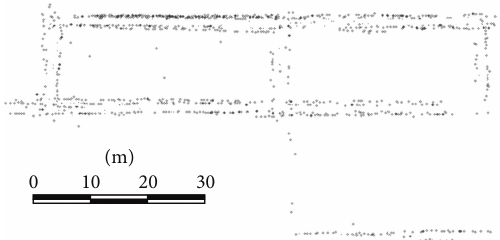
algorithm, showing the landmarks added to the map, representing the structure of the environment. All measurements are in meters. The experiment was conducted under incandescent ambient light-